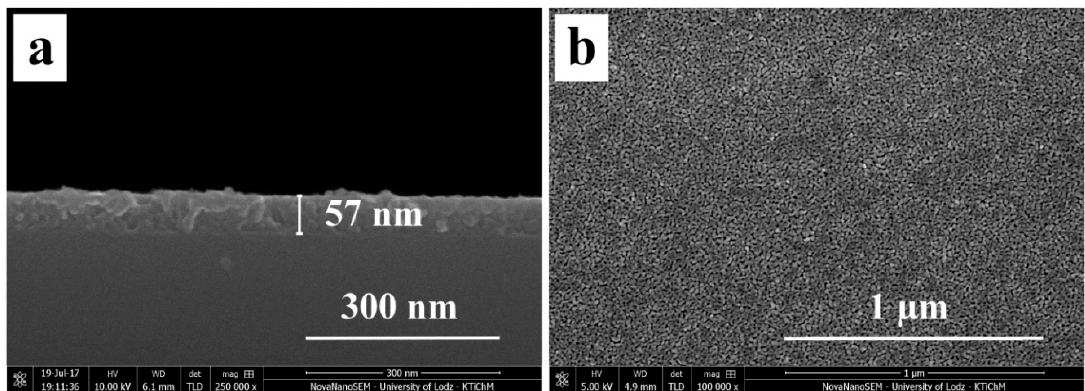
Figure 3. Scanning electron microscopy (SEM) characterization of bare TiO 2 coating: ( a ) cross-view, ( b ) top-view.